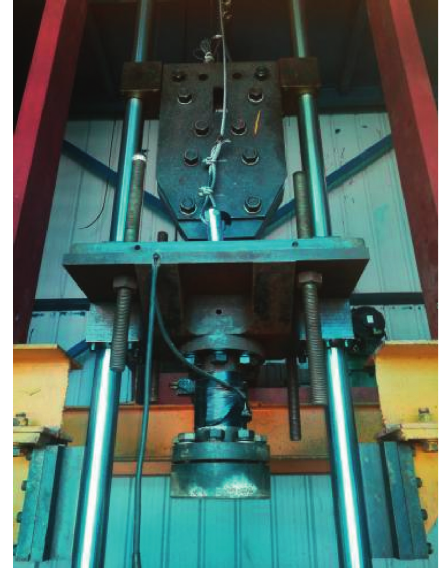
Figure 7: Vertical drop hammer.